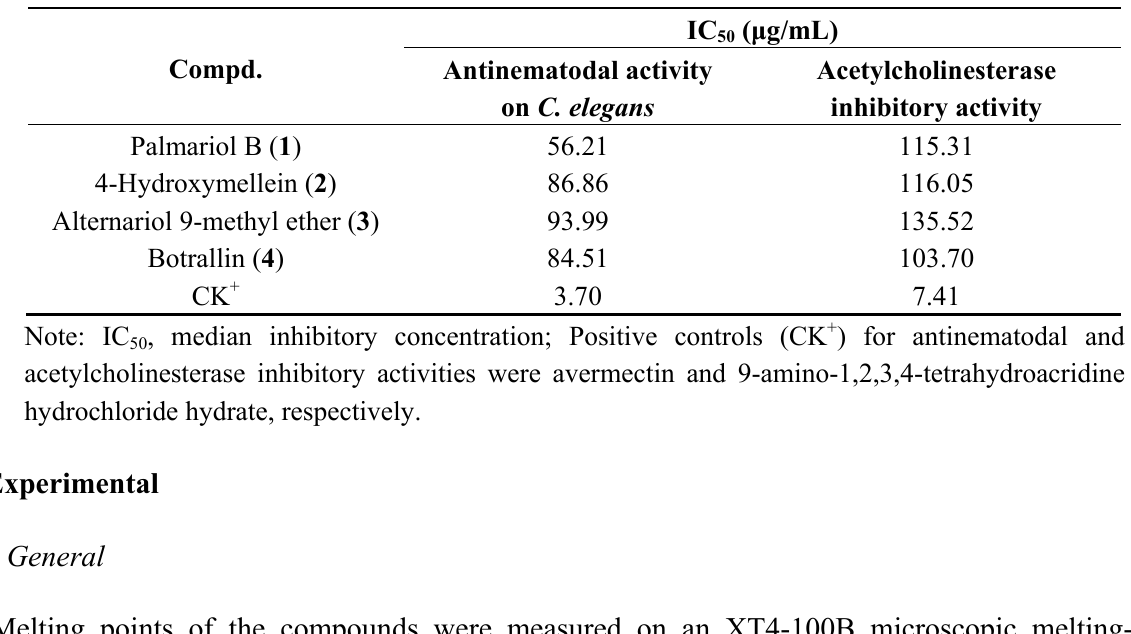
2. Antinematodal activity on the nematode Caenorhabditis elegans and acetylcholinesterase inhibitory activity of the benzopyranones. Compd.